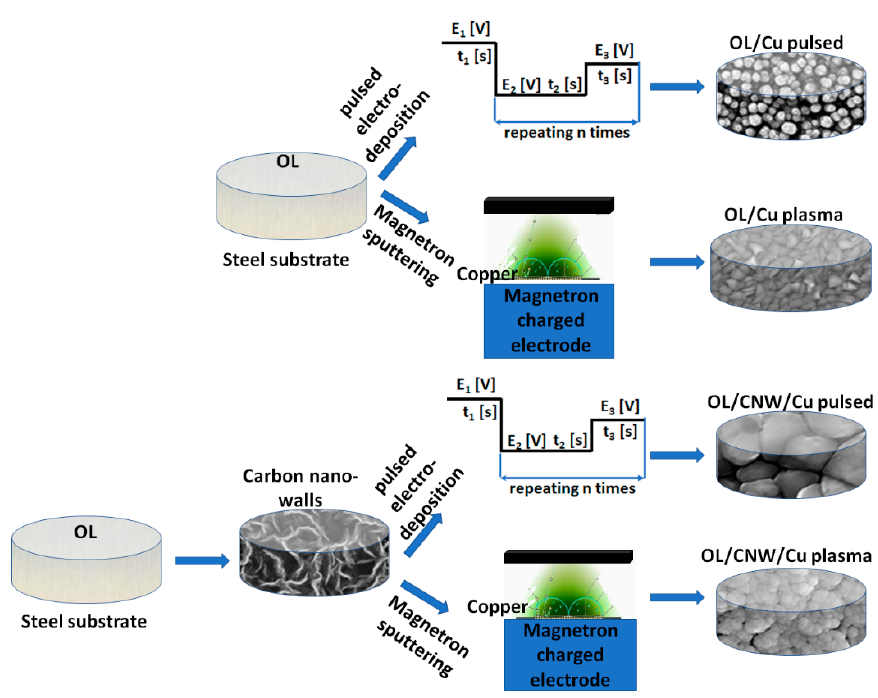
Figure 1. Copper deposition on OL substrate and OL/CNW.